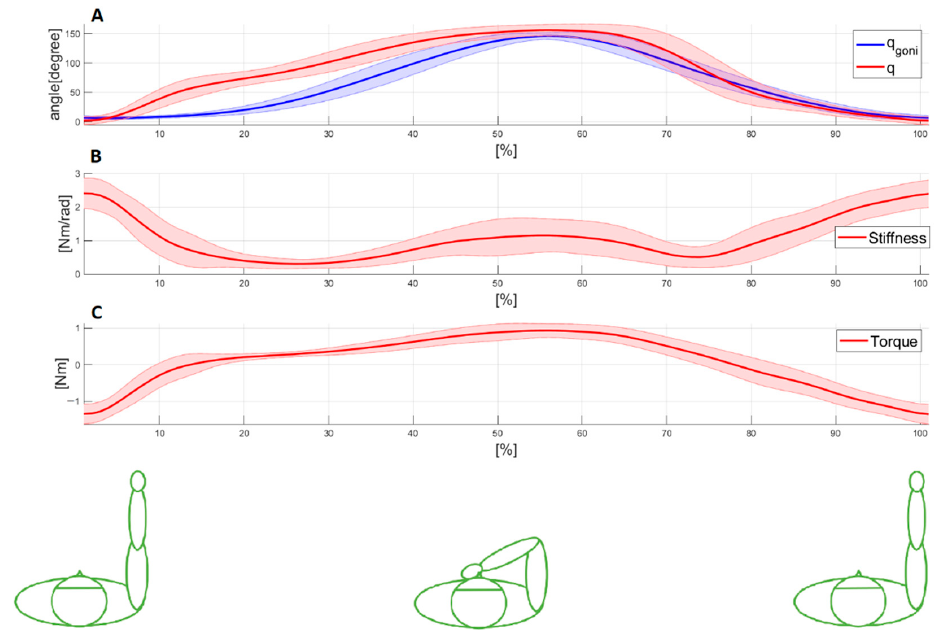
negligible. It can be observed that in the DWT value for l tc , l ts is high, because the algorithm for stiffness diverged after parameter modification.